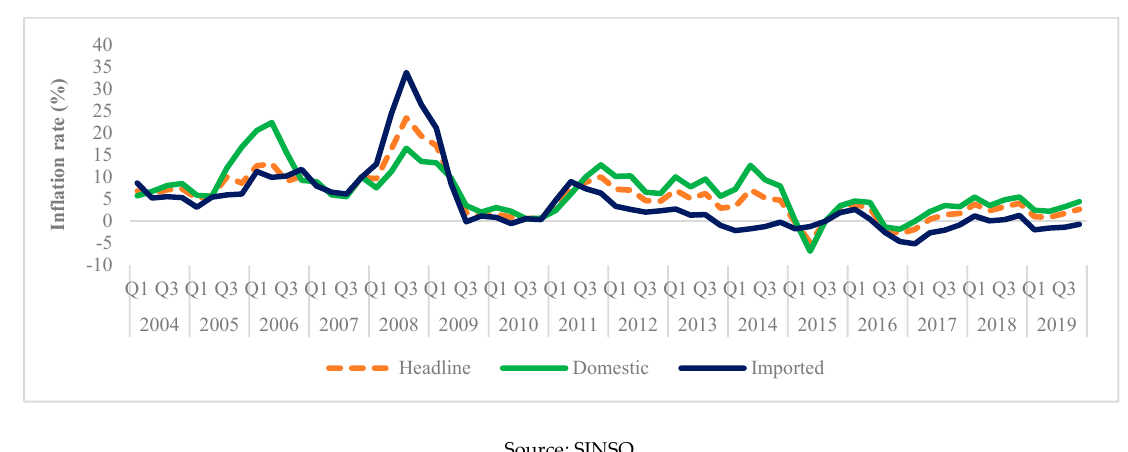
Figure 4. Headline, imported and domestic inflation rates in Solomon Islands, 2004Q1–2019Q4. Data from Central Bank of Solomon Islands (CBSI